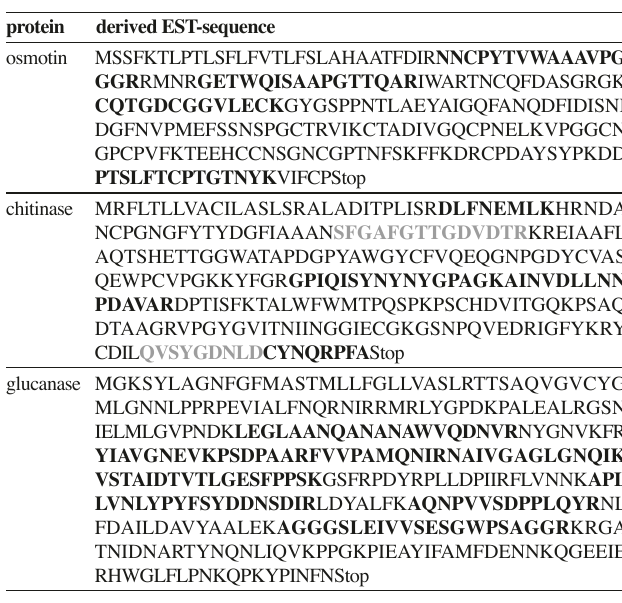
Fig. 10: SDS gel electrophoresis of the proteins and peptides from TA- mucilage. MWM = molecular weight marker, S = TA-mucilage, the numbers mark the visible proteins later identified by HPLC-MS 1 = osmotin, 2 = chitinase, 3 = glucanase, 4-17 = unidentified proteins. Tab. 2: Proteins identified by their derived EST sequences. The sequences in bold, correspond exactly to those found in the EST sequences of the corresponding protein, whereas the sequences in gray only partially coincide.